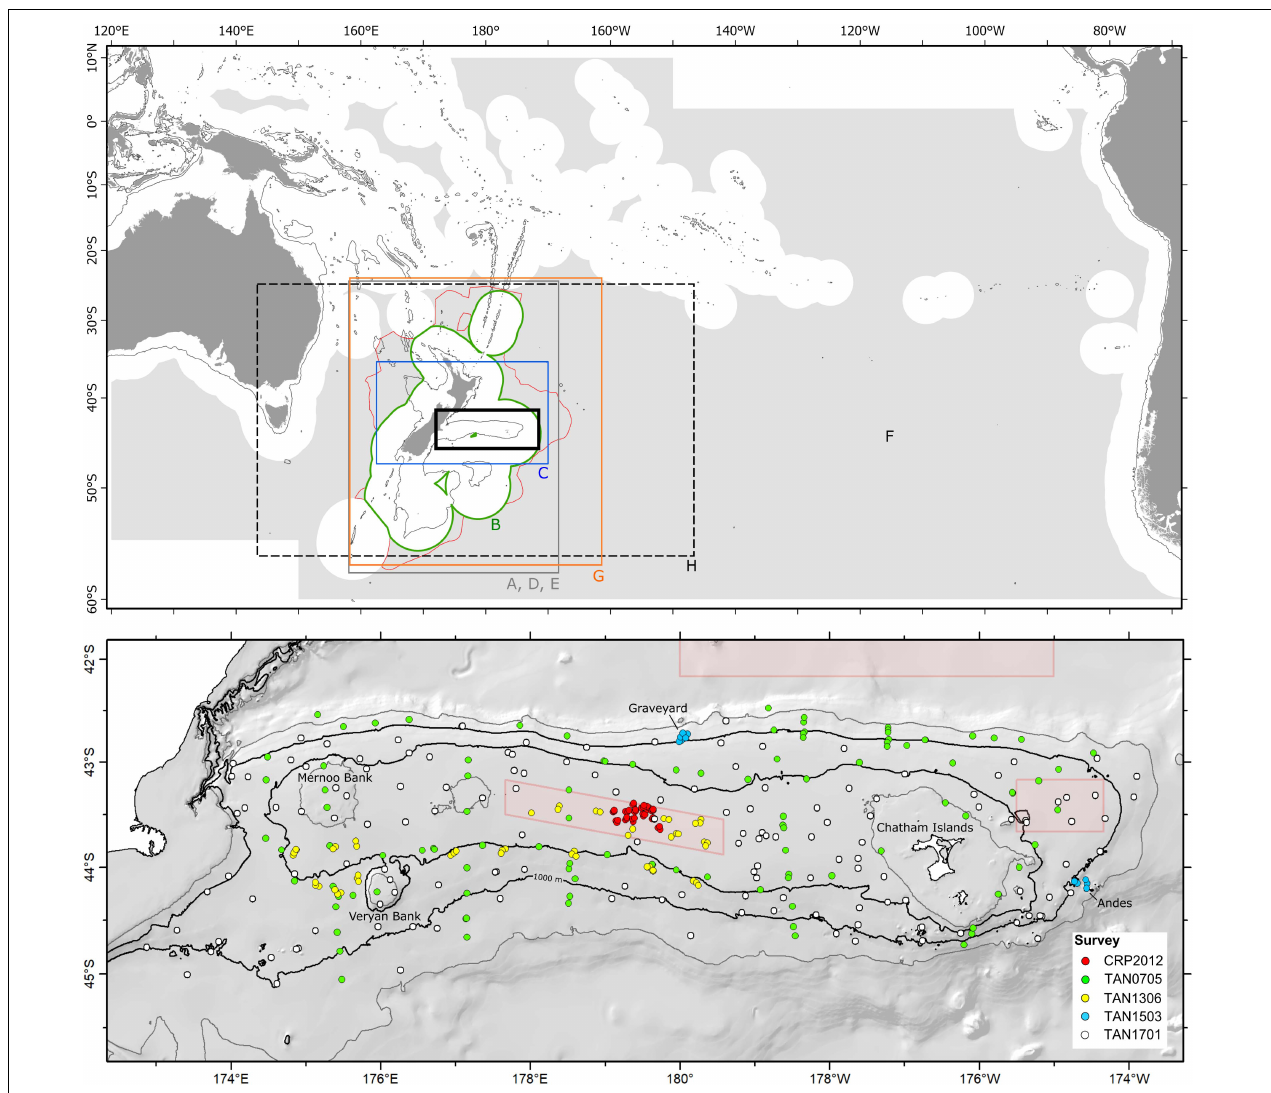
FIGURE 1 | (Top) areas of eight published studies from which predictive models were assessed: A, Tracey et al. (2011); B, Baird et al. (2013); C, Compton et al. (2013); D, Anderson et al. (2014); E, Anderson et al. (2015); F, Anderson et al. (2016a), G, Anderson et al. (2016b); and H, Georgian et al. (2019). Boundary B is the New Zealand Exclusive Economic Zone (EEZ). Also showing New Zealand’s Extended Continental Shelf boundary (red polygon), the 1,000-m isobath, and Chatham Rise (bold black rectangle). (Bottom) Chatham Rise showing the location of DTIS photographic transect stations (color-coded points, see legend) for the five surveys from which the independent test dataset was developed. The Graveyard and Andes seamount complexes are indicated, isobaths show 250-, 500-, 1, 000-, and 1,500-m depths, and red polygons show Benthic Protection Areas (BPAs), which are protected from seabed trawl